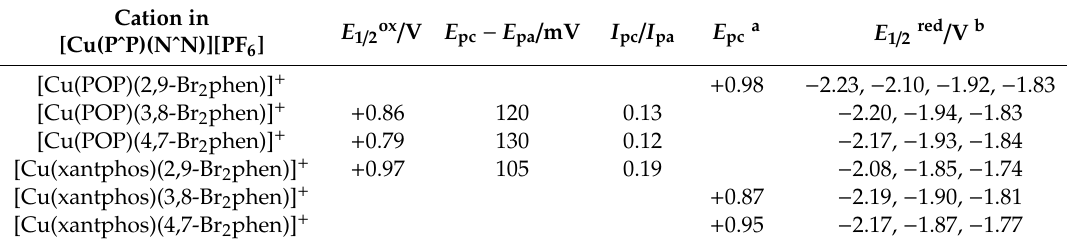
Table 2. Cyclic voltammetric data for [Cu(P^P)(N^N)][PF 6 ] complexes referenced to internal Fc/Fc + =